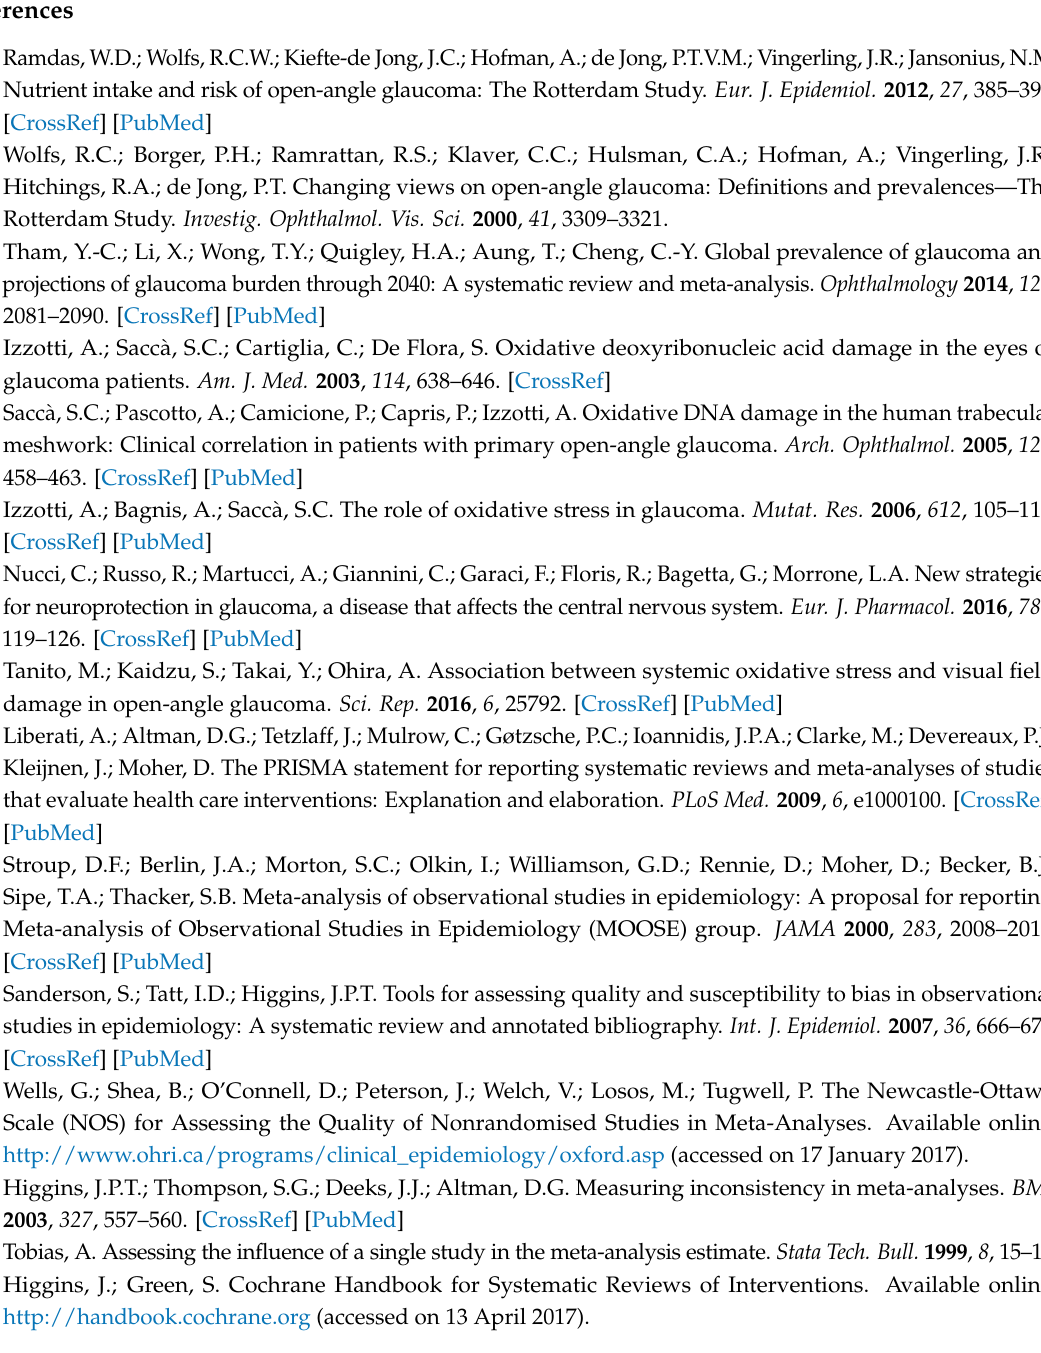
Table S1: Summary of the retrieved studies from the systematic review; Table S2: Quality assessment of included studies according to the Newcastle-Ottawa Scale *; Table S3: Blood levels of studies on vitamin blood levels and glaucoma; Table S4: Overview of retrieved studies on the association of vitamin blood levels with open-angle glaucoma; Table S5: Overview of retrieved studies on the association of vitamin blood levels (in bold) and intake with open-angle glaucoma; Table S6: Evidence for association of vitamins with open-angle glaucoma: Judgement of